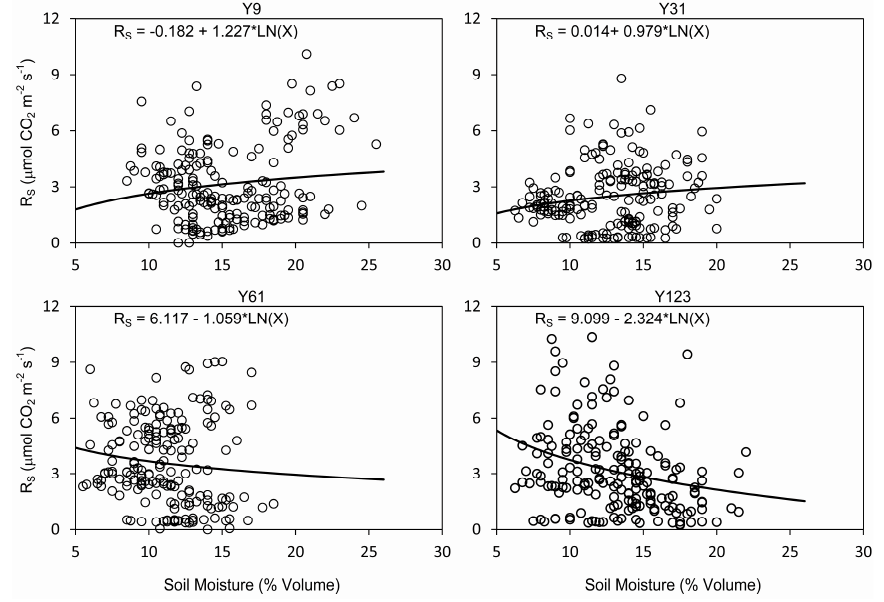
Figure 4. Relationships between soil respiration (R S ) and soil moisture in 9 (Y9), 31 (Y31), 61 (Y61), and 123 (Y123) year-old red pine stands in northern Minnesota, USA.